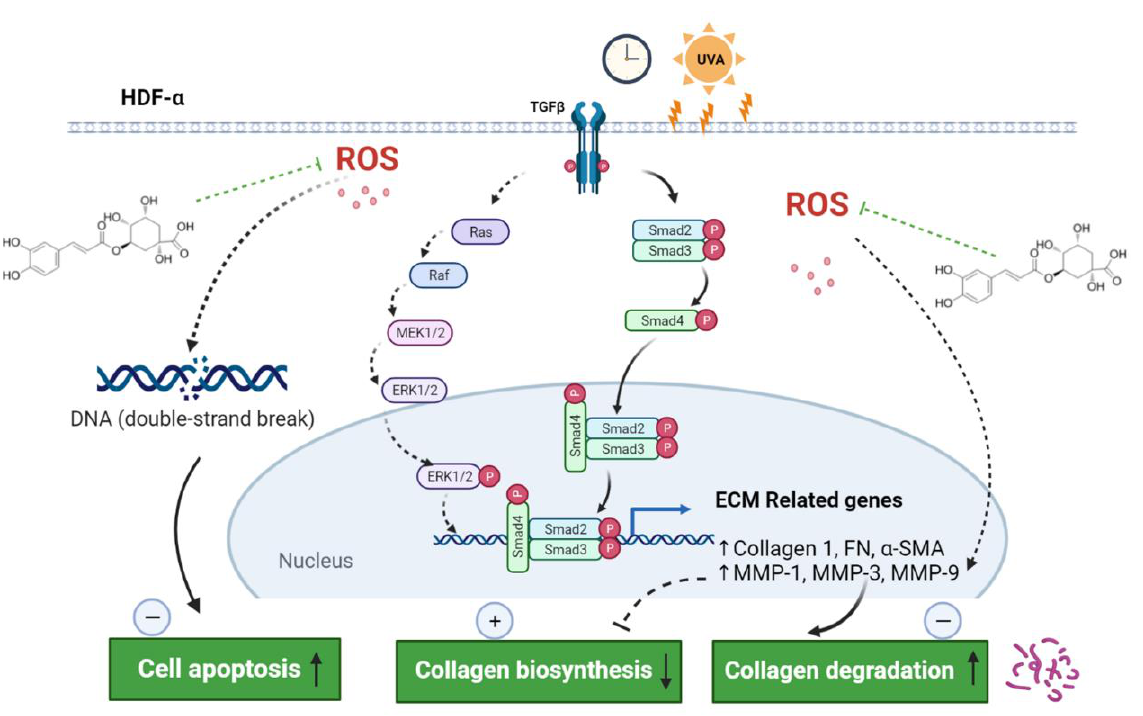
Figure 7. Schematic representation of the photoprotection of CGA on HDF- α cells. CGA promoted the collagen 1 synthesis through TGF- β -Smad2/3 signaling, and inhibited the collagen degradation by downregulating the MMP-1 and MMP-3. In addition, CGA reduced the accumulation of UVA-induced ROS, attenuated the DNA damage and promoted cell repair, resulting in inhibition the cell apoptosis. Green dotted T bars, potential inhibition; straight arrows, activation; dotted arrows, potential activation. ECM, extracellular matrix; MMP, matrix metalloproteinase; ROS, reactive oxygen species.